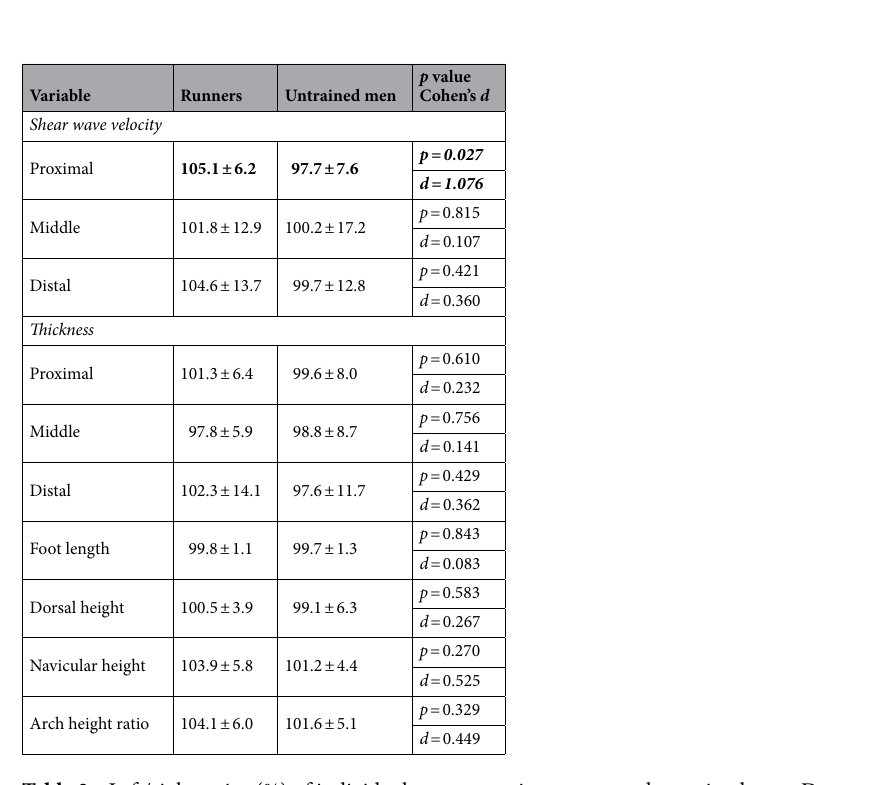
Table 1. Bilateral differences in foot dimensions of runners and untrained men. Data are shown as means ± SD.